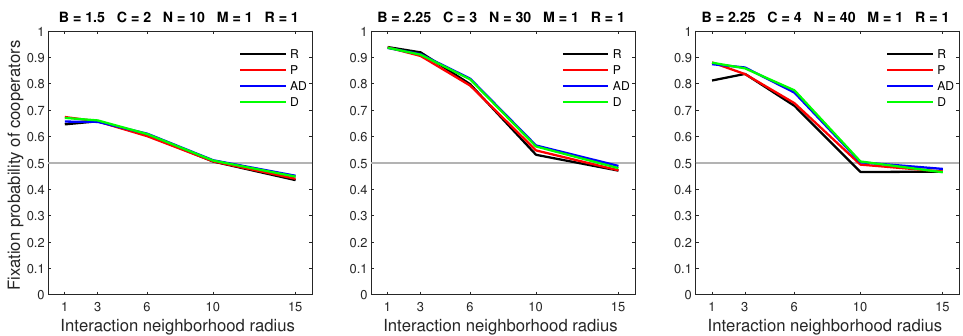
Figure 16. All models result in similar fixation probabilities when the mobility rate is low and the dispersal range is small. Legend: R—random dispersal, P—probabilistic dispersal, AD—almost deterministic dispersal, D—deterministic dispersal.